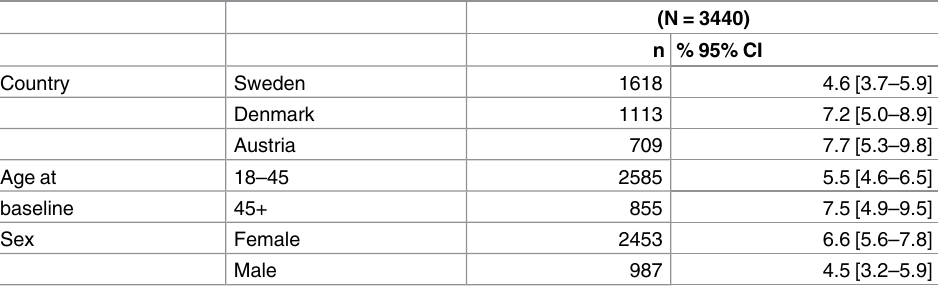
Table 2. Estimated cumulative probabilities of ADA development before six months of natalizumab